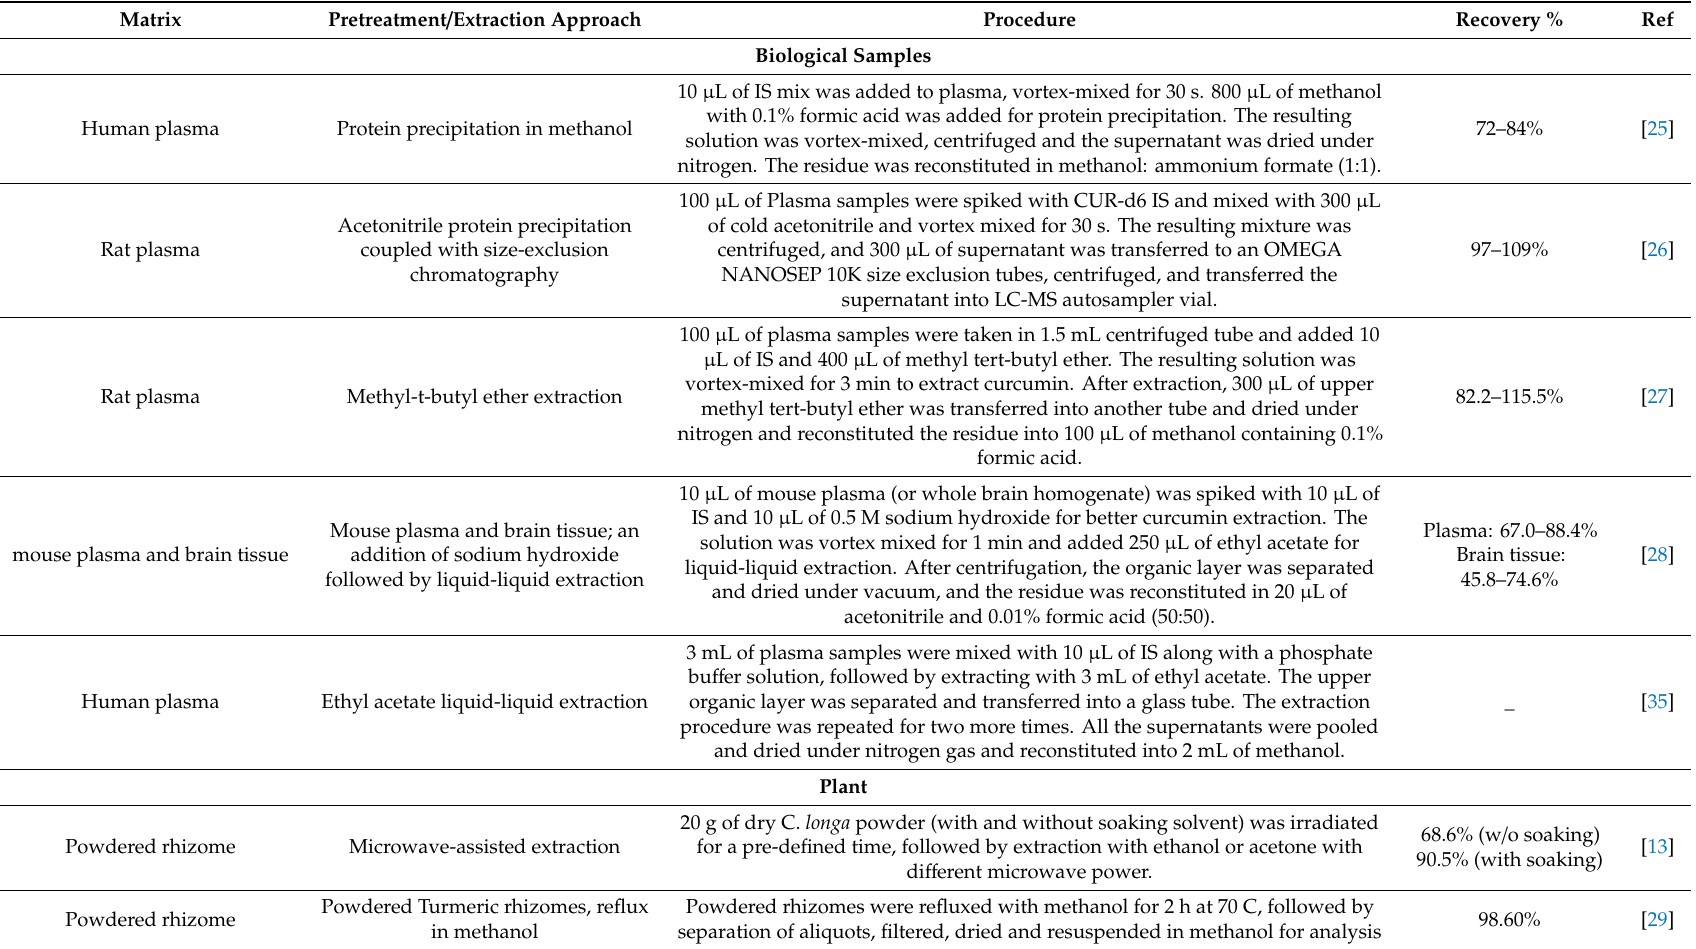
Table 2. Several sample preparation techniques used for the extraction of